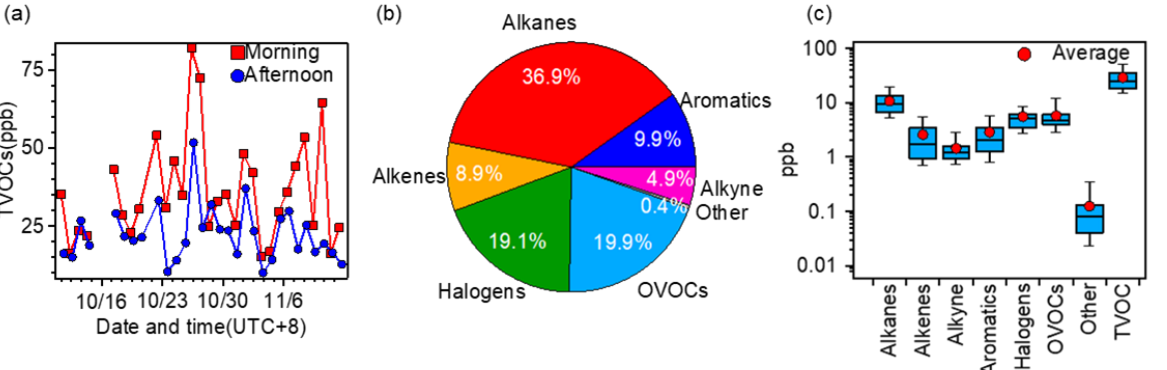
Figure 3. ( a ) Temporal variations of TVOC concentrations in the morning and afternoon, ( b ) mass contributions of different VOCs to TVOC, and ( c ) box plots of concentrations of different VOCs (the whiskers above and below the boxes mark the 90% and 10% percentiles, respectively; the upper and lower edges of the boxes represent the 75% and 25% percentiles, respectively; and the lines and red dots inside the boxes denote the median and mean values, respectively).